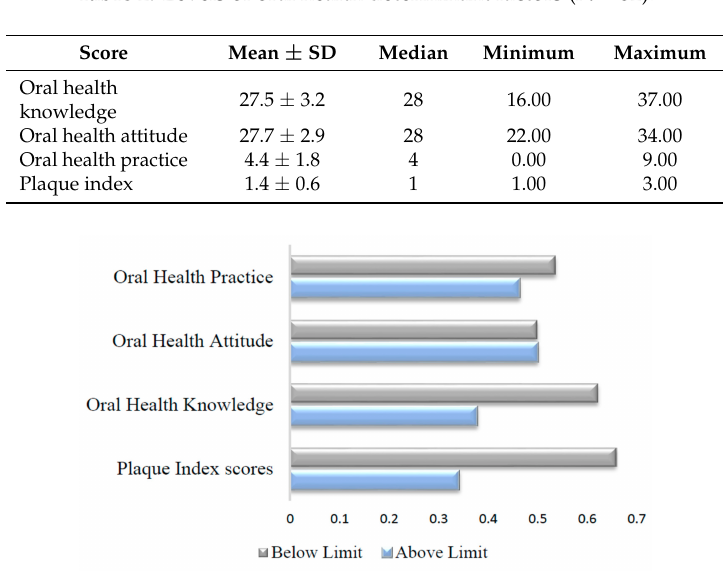
Table 2. Levels of oral health determinant factors (N = 82).